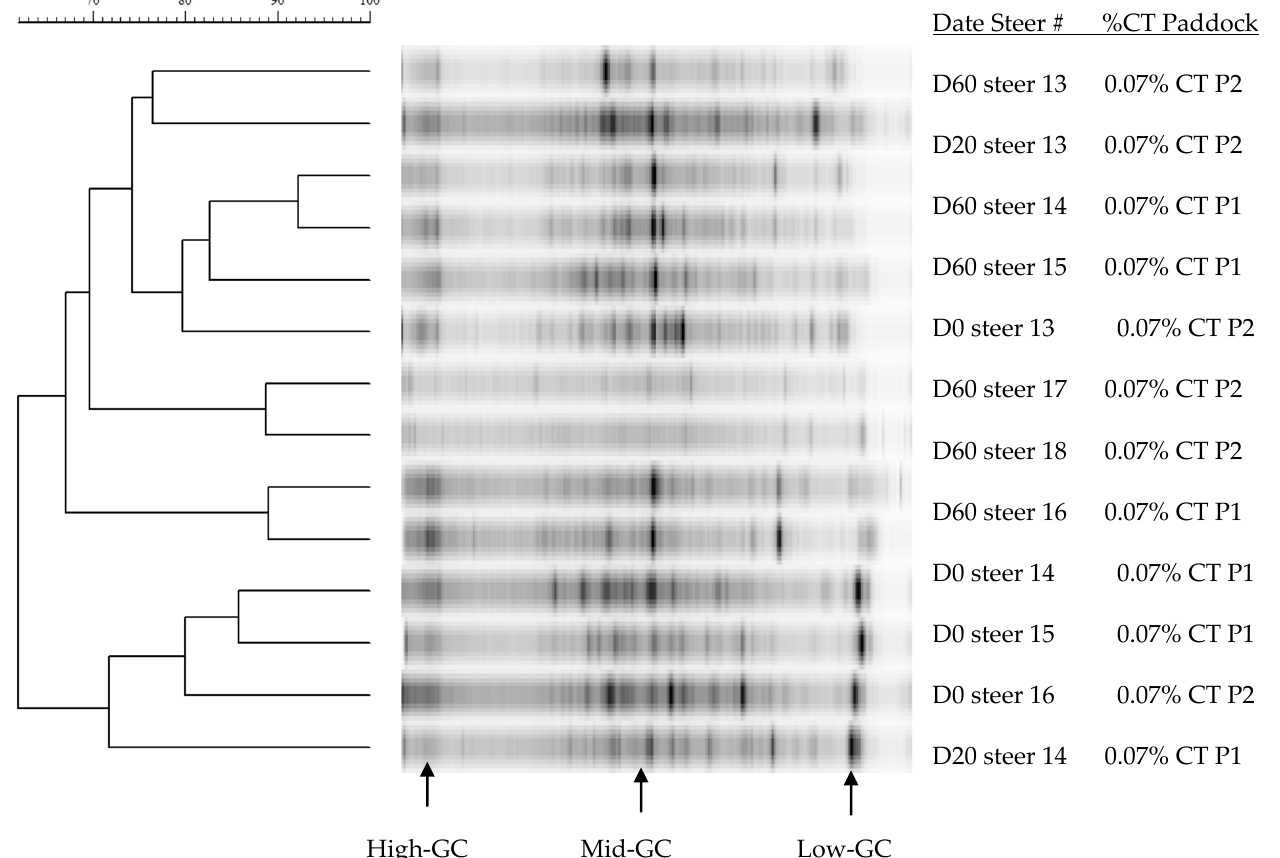
Figure 4. Dendrograms of denaturing gradient gel electrophoresis gels of rumen bacteria 16S rDNA amplicon bands patterns in steers (n = 4 to 5) given winter wheat forage for day 0, day 20, and day 60 and containing 0.07% condensed tannins (CT; %/kg BW). Cattle tag numbers (#) of 17 and 18 were missed on day 0 and day 20. P1 to P2 = each paddock (P). The bar above the figure indicates Dice percentage similarity coefficients (%SC). D = day, GC= guanines and cytosines, and Steer # = tag number (#). Table 4. Effects in rumen fluid from steers fed condensed tannins (CT) on in vitro ruminal gas and methane (CH 4 ) gas production when incubated with minced fresh wheat forage